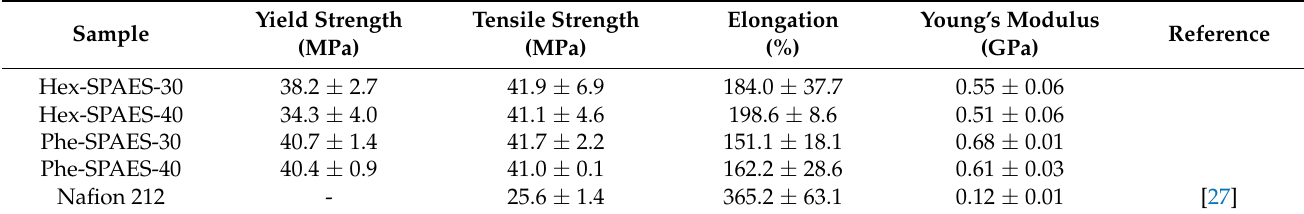
Table 3. Mechanical properties of the synthetic polymer membranes.